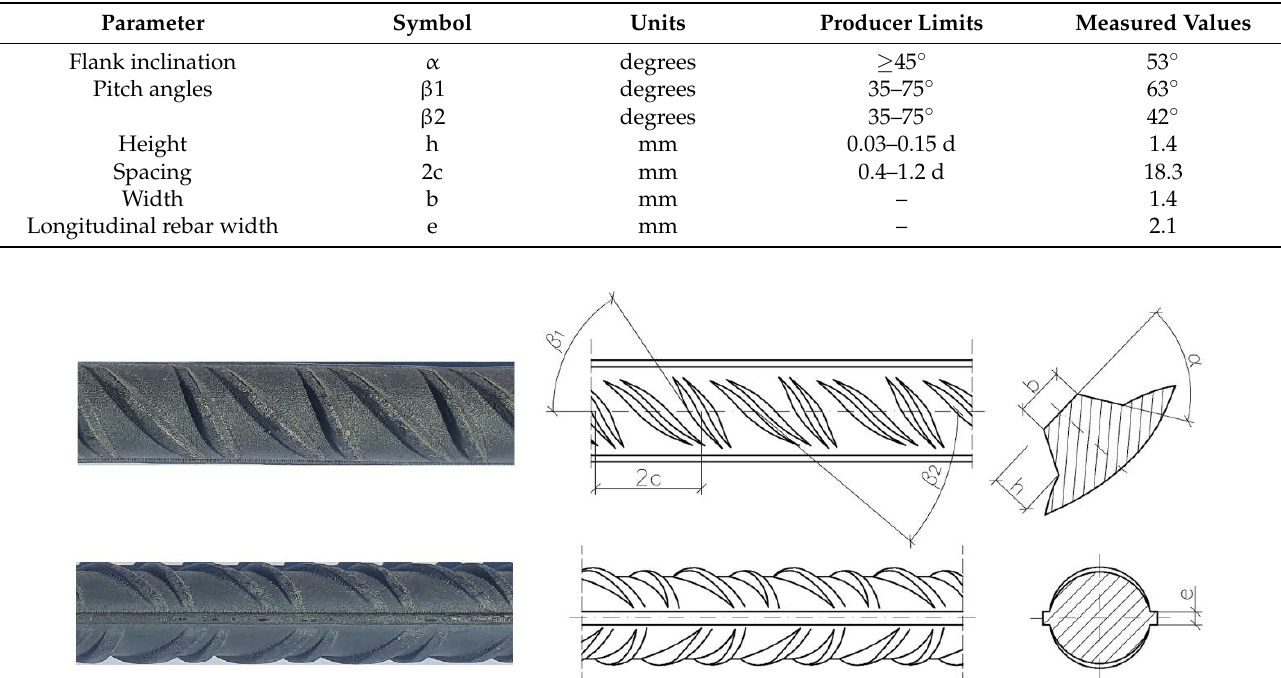
Table 2. Characteristics of surface and ribs of reinforcing bars (B500SP).